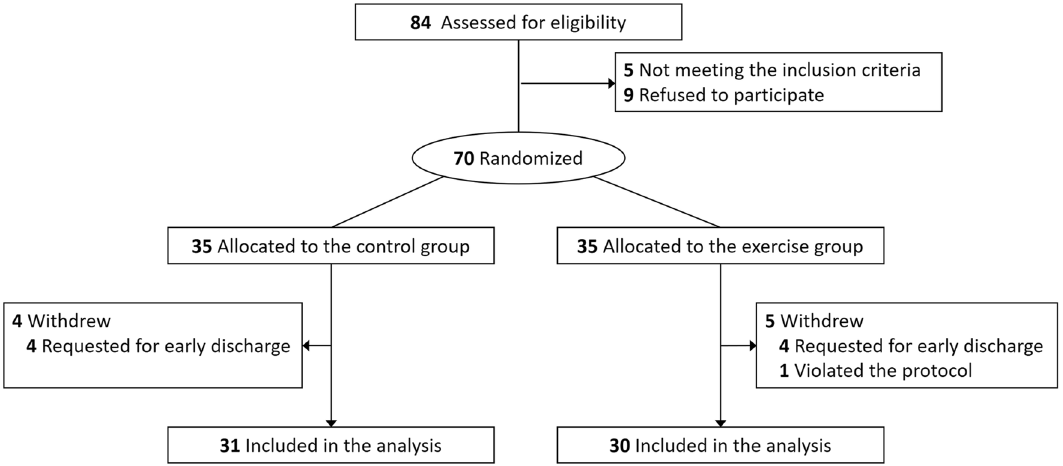
Figure 1. CONSORT flow diagram showing participant screening, recruitment, and